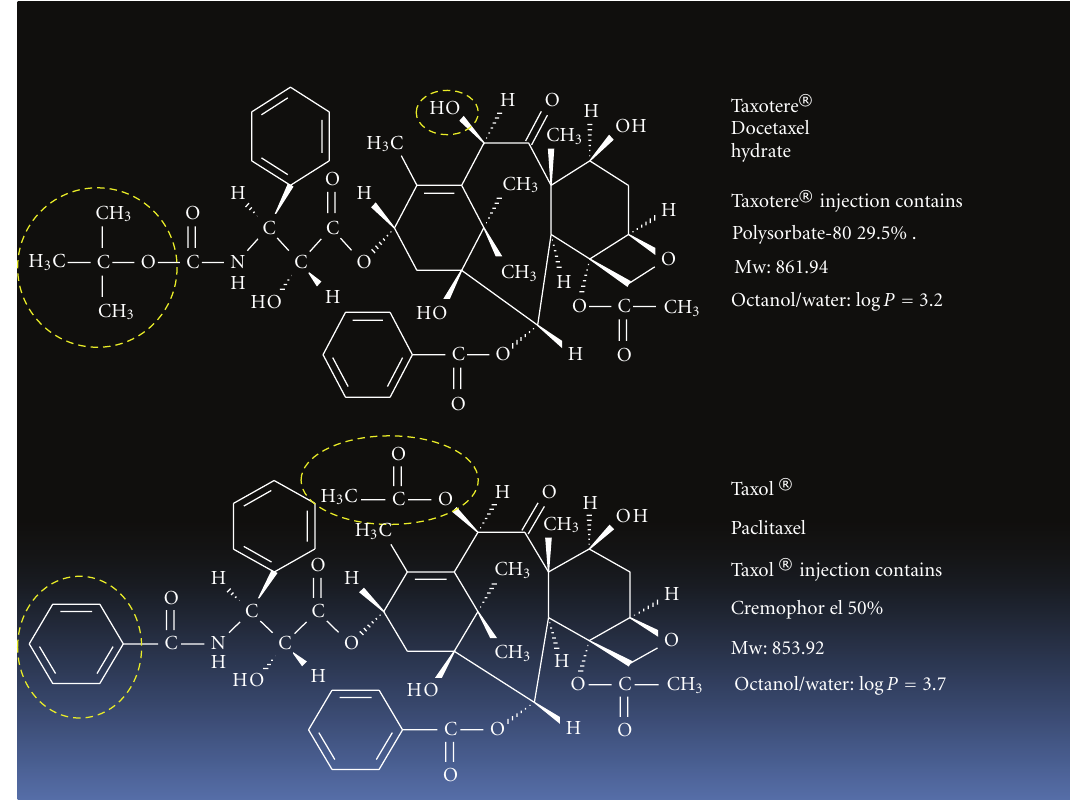
Figure 1: Chemical structures of taxane anticancer drugs. Circles indicate the di ff erences between docetaxel and paclitaxel.